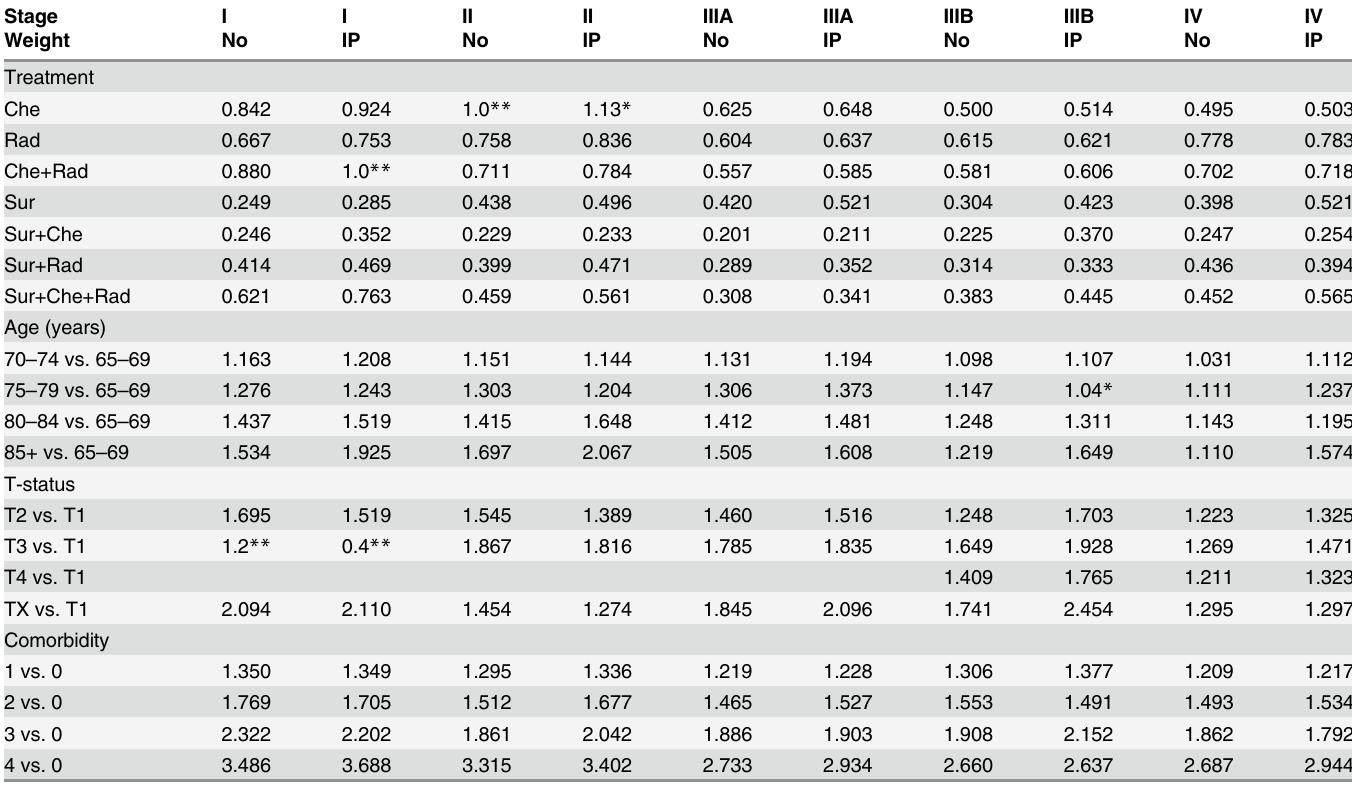
Table 3. The causal effect of the lung cancer treatment modes (represented by HRs) evaluated in the Cox model for original and pseudorando- mized population for one-year follow-up for treatments involving surgery (Sur), radio- (Rad) and chemotherapy (Che) vs. no treatment.